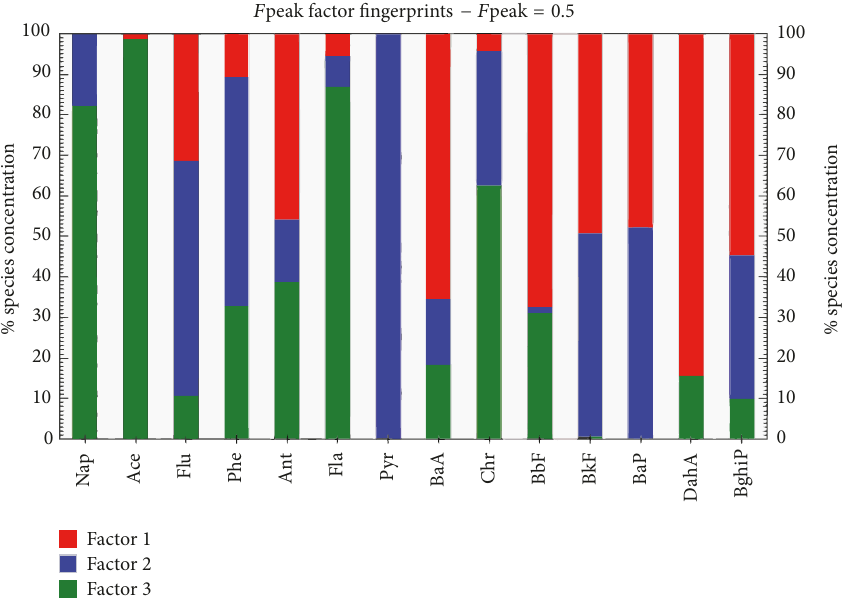
Figure 5: Factor fingerprints of three PMF factors in each of the individual